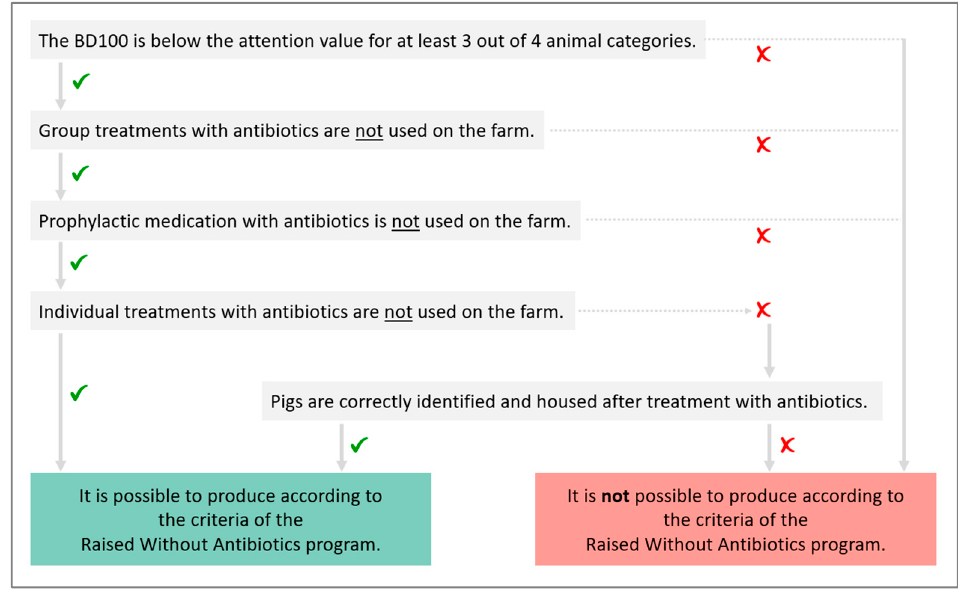
Figure 3. Flow chart to decide if a farm can produce according to the criteria of the Belgian Raised Without Antibiotics program.